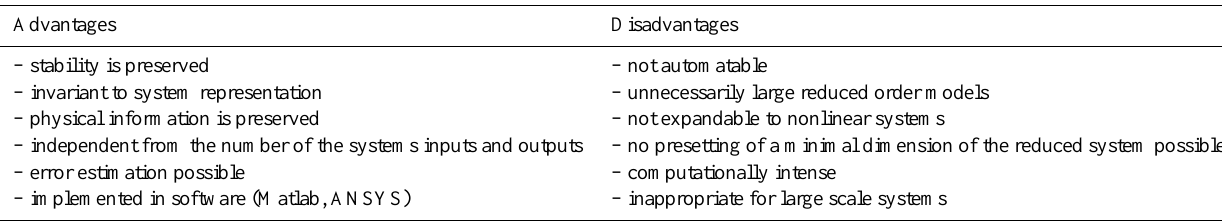
Table 1. Characteristics of condensation-based